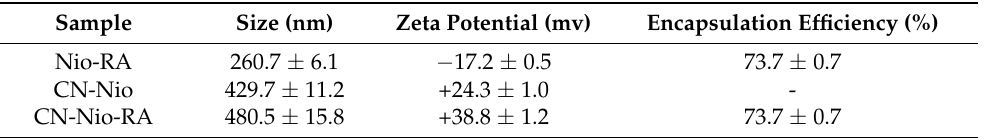
Table 1. Average size, zeta potential and encapsulation efficiency of uncoated niosomes loaded with rosmarinic acid (Nio-RA), empty chitosan and nutriose-coated niosomes (CN-Nio) and chitosan and nutriose-coated niosomes loaded with RA (CN-Nio-RA). Sample Size (nm) Encapsulation Efficiency (%)